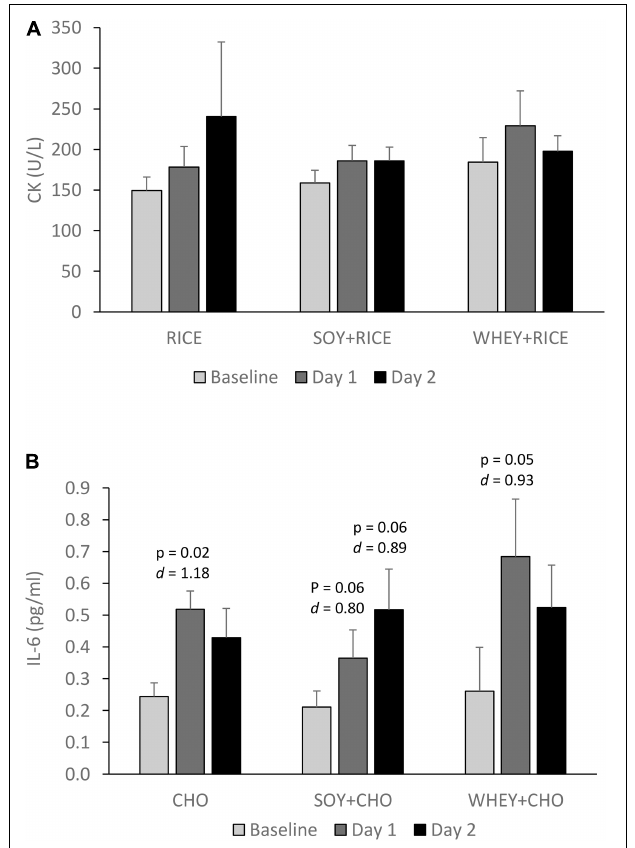
FIGURE 4 | Plasma IL-6 (A) and CK (B) responses 1 h after exercise are similar for RICE alone drink ( n = 7), SOY-RICE drink ( n = 7), and WHEY-RICE drink ( n = 7) at Day 1 and Day 2. RICE alone drink (carbohydrate, 95%, protein, 4%; fat, 1%), SOY-RICE drink (carbohydrate, 82%, protein, 10%; fat, 8%), and WHEY-RICE drink (carbohydrate, 76%, protein, 20%; fat, 4%) in calorie.